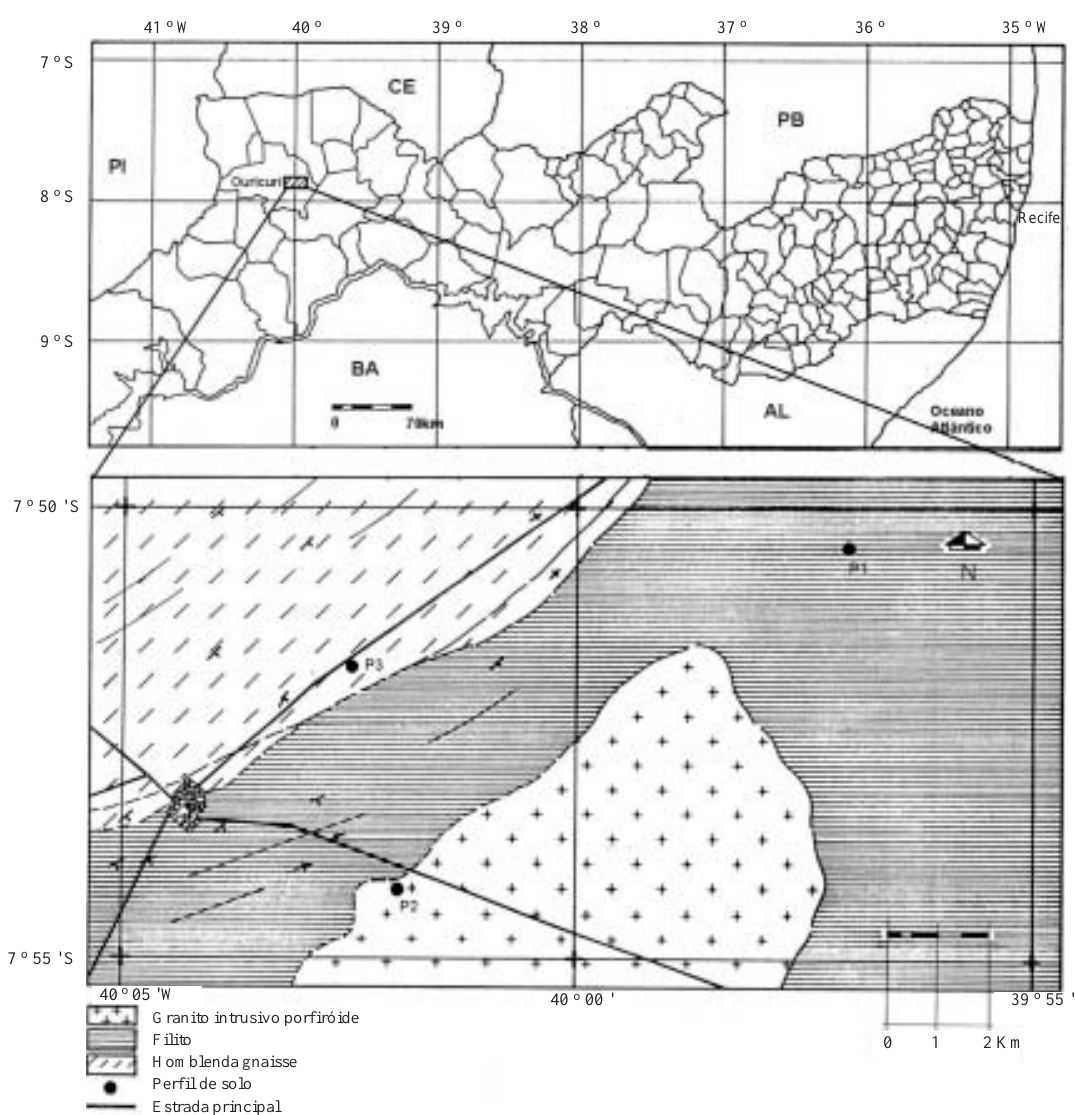
Figura 1. Localização da área de estudo, mapa geológico com a localização dos perfis de solo estudados [adaptado de Caldasso (1967) e Veiga